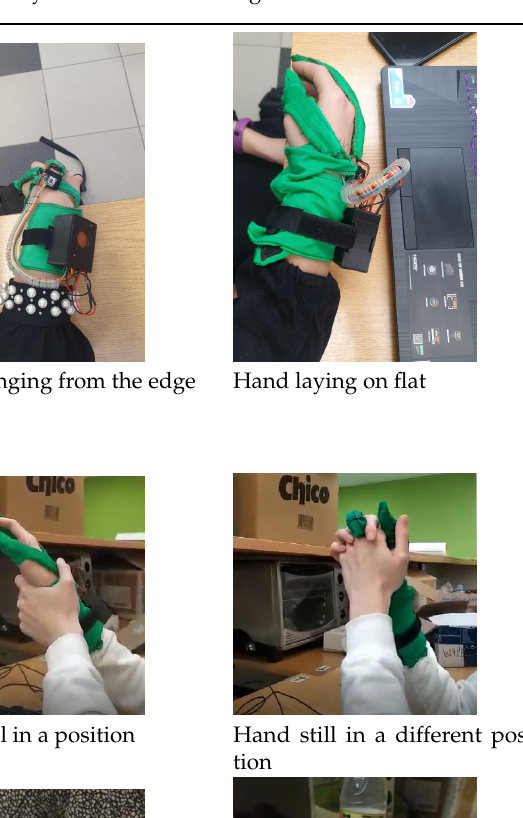
Table A1. Variety of anomalies used in anomaly classification